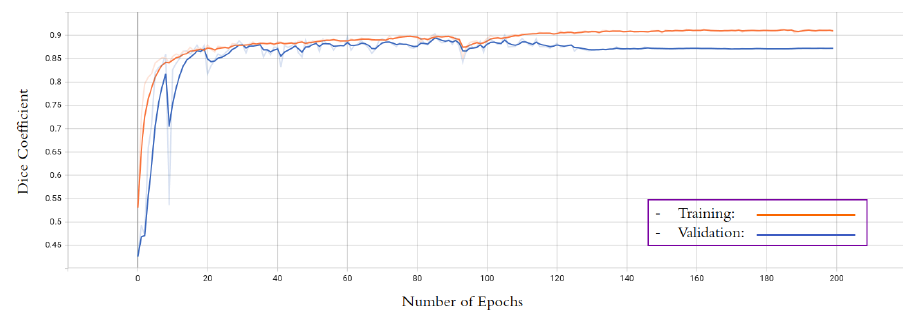
Figure 8. The training and testing processes evaluated by the Dice